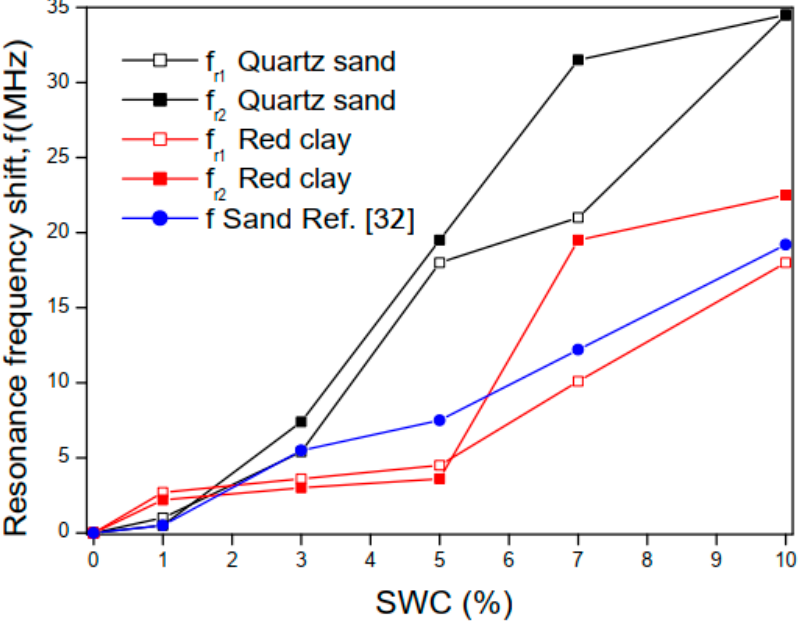
Figure 11. Measured results for the resonance frequency shift on quartz sand and red clay soil samples for different water concentrations.